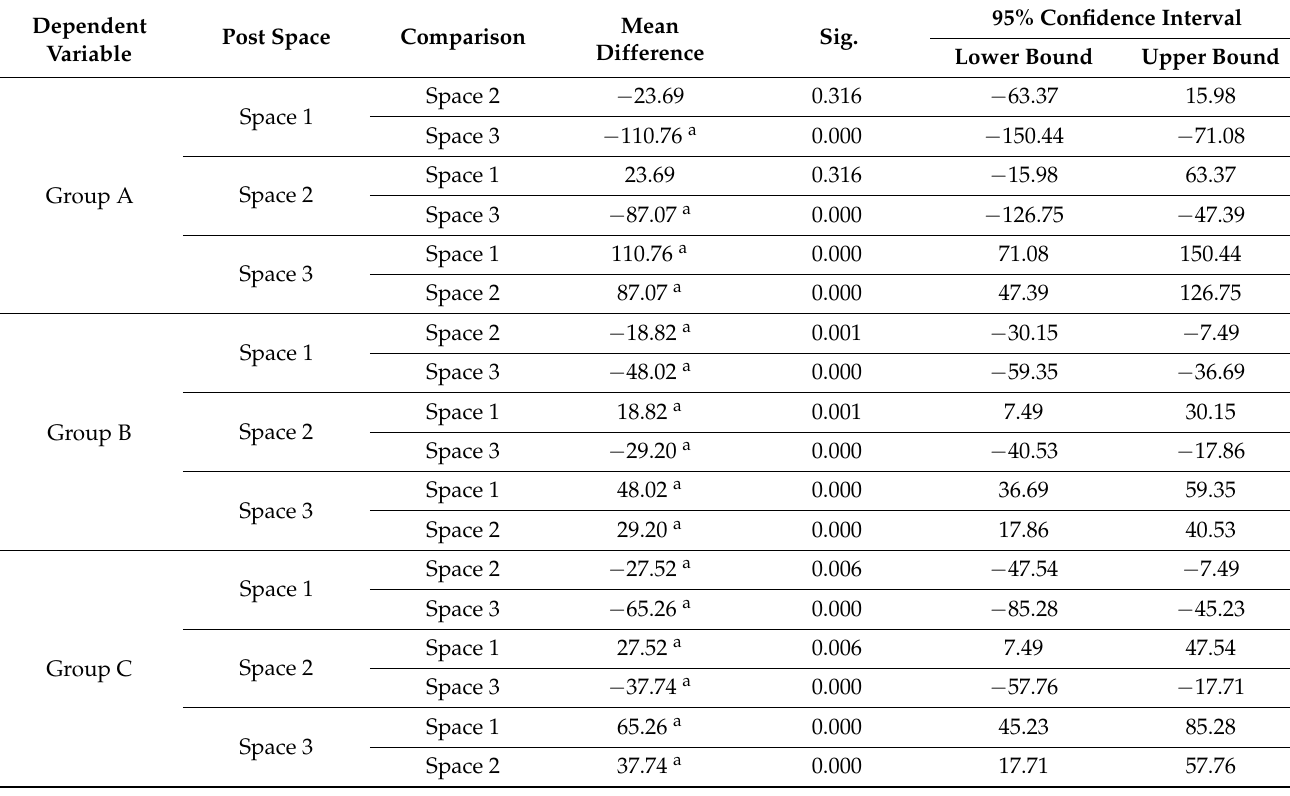
Table 5. Multiple Comparisons and mean differences of the test specimens with different post spaces by post-hoc Tukey HSD test. Dependent Variable